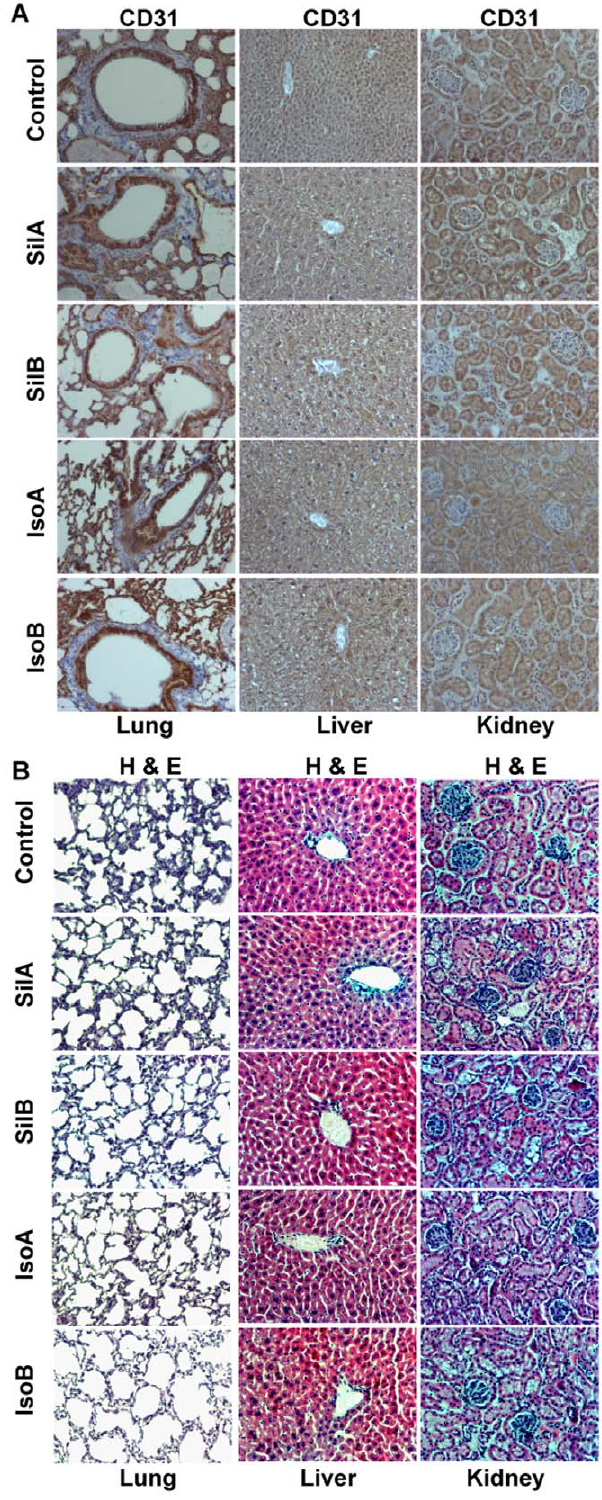
Figure 4. Feeding of pure flavonolignans did not affect angiogenesis and normal histology in non-target organs. ( A– B ) Lungs, liver and kidneys from each mouse were collected and analyzed for CD31 immunoreactivity as well as for histopathological analyses. Quantitative analyses were performed using Zeiss Axioscope 2 microscope (Carl Zeiss, Germany) and photographs were